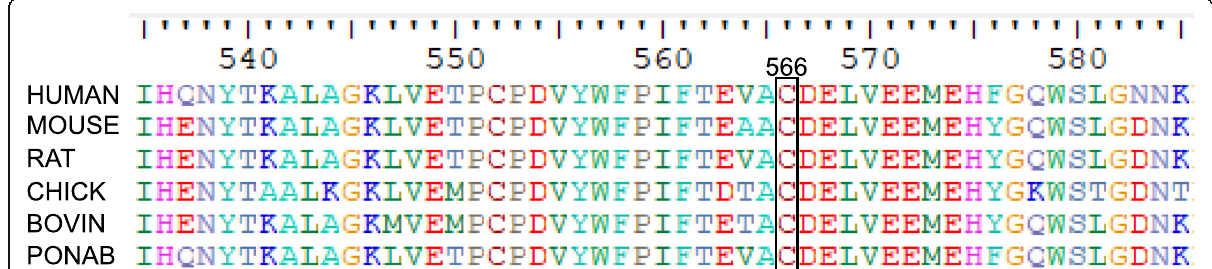
Fig. 4 Sequence alignment of human PLOD1 with other species. Number and black box indicates the mutant residue in human PLOD1. The amino acid cysteine at position 566 is highly conserved among different